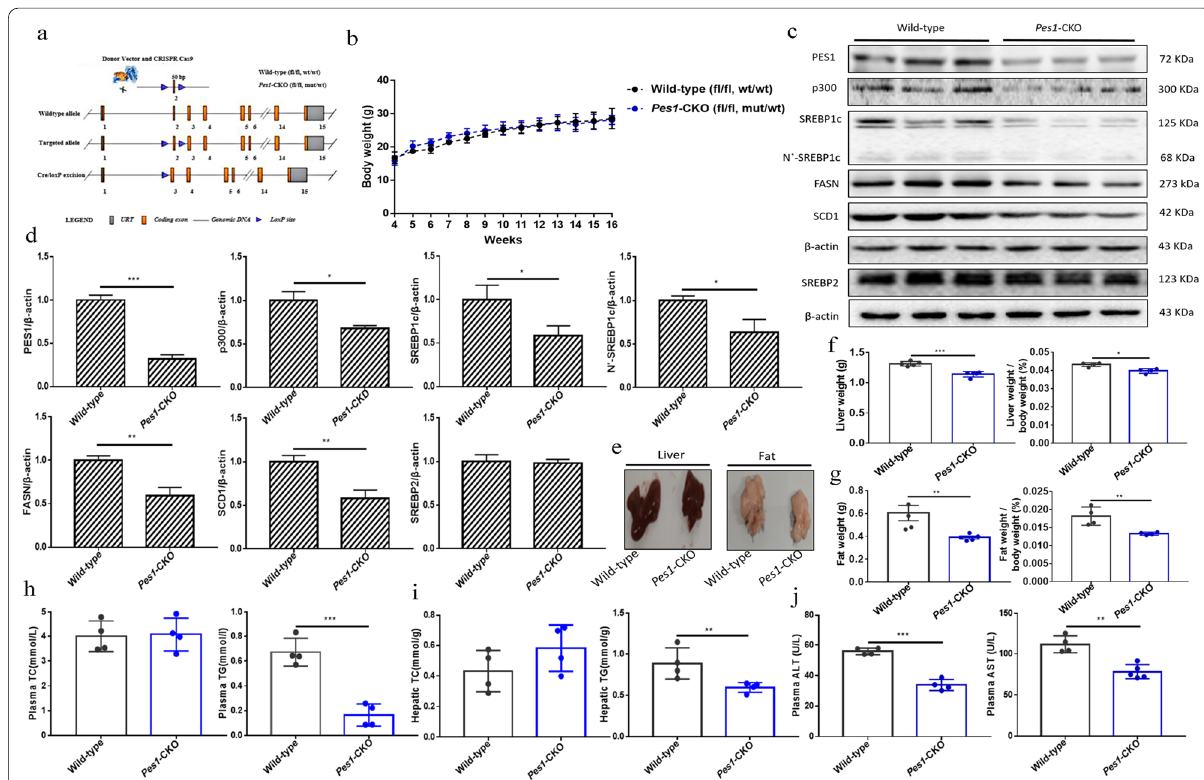
Fig. 5 Effects of liver-specific Pes1 knockout on lipid metabolism in vivo. a Displayed is the scheme of Pes1 gene knockout strategy. b Shown are the effects of Pes1 knockout on the murine body weights. c , d Pes1 knockout in mice eliminated the protein levels of PES1, and inhibited p300, SREBP1c, FASN and SCD1 proteins. e – g Shown are the effects of Pes1 knockout on the weights of livers and fat. h , i Demonstrated are the effects of Pes1 knockout on the TG and TC levels in murine plasma and livers. j Plasma AST and ALT levels were measured by Reagent kit. Data were shown as mean SEM for each experiment performed independently 3 times. *P < 0.05, **P < 0.01, ***P < 0.001 compared with control (Student’s t ±